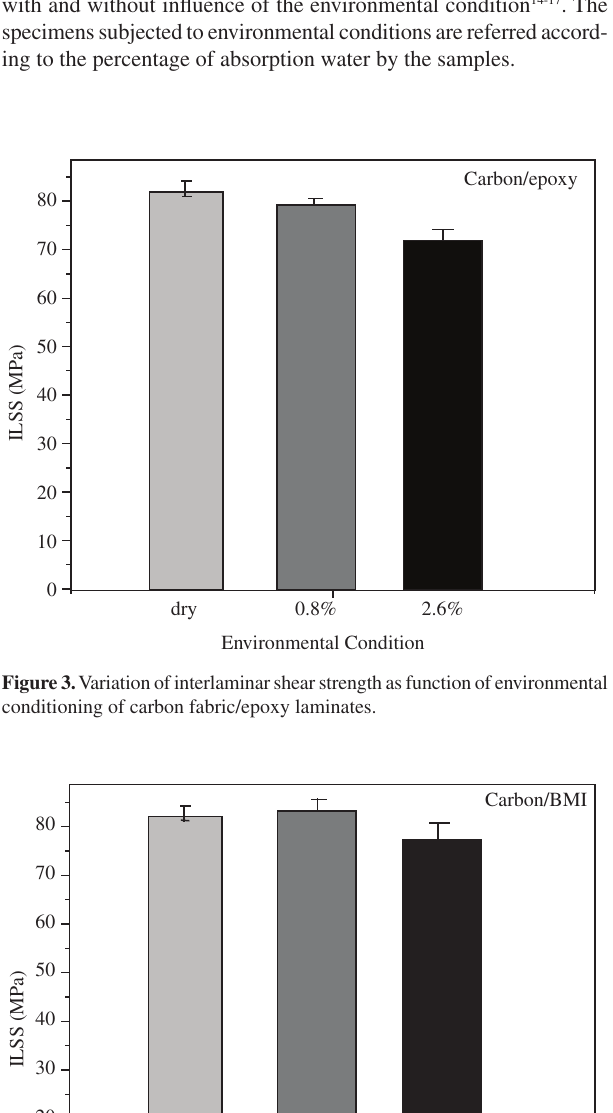
Figure 4. Variation of interlaminar shear strength as function of environmental conditioning of carbon fabric/BMI laminates.